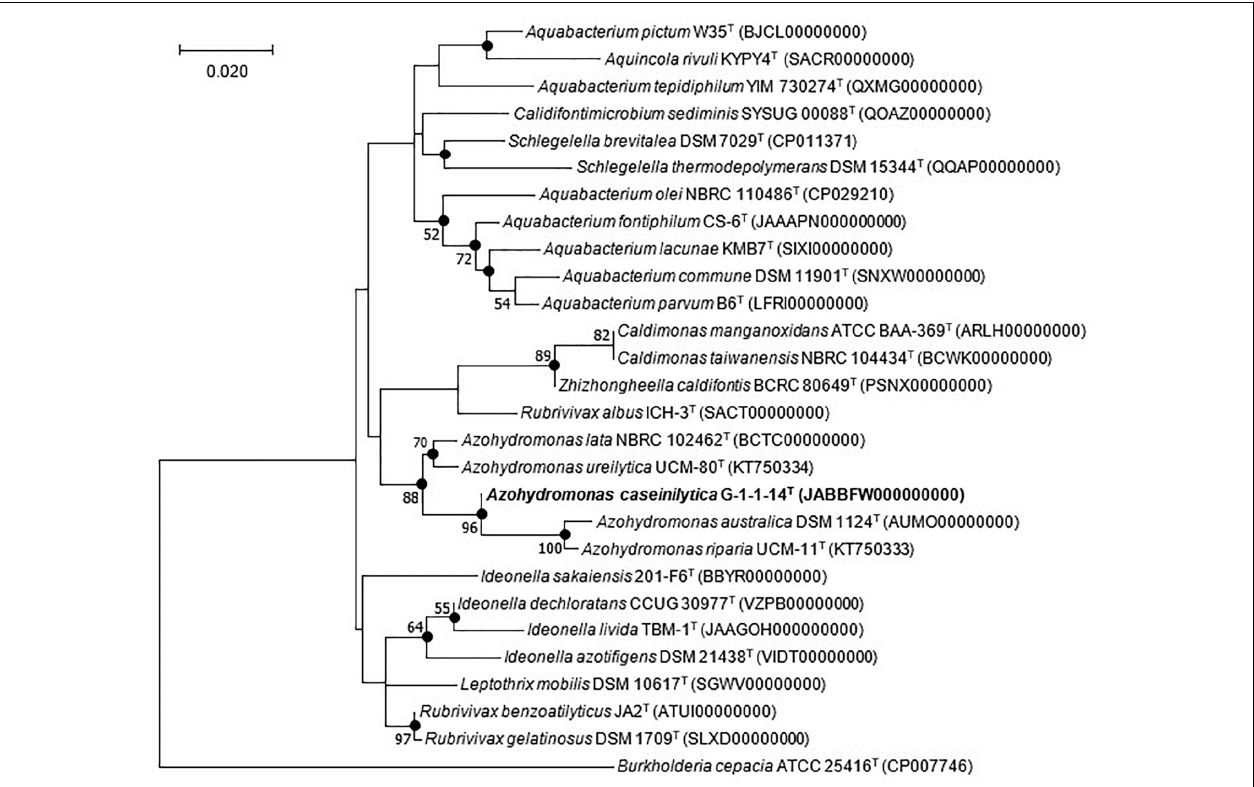
FIGURE 1 | Maximum likelihood tree based on 16S rRNA gene sequences showing the phylogenetic position of strain G-1-1-14 T among the closely related members of the order Burkholderiales. Filled circles indicate nodes recovered by all three treeing methods (neighbor-joining, maximum likelihood, and maximum parsimony). The numbers at the nodes indicate the percentage of 1,000 bootstrap replicates yielding this topology; only values > 50% are shown. Burkholderia cepacia ATCC 25416 T was used as an outgroup. The GenBank accession numbers are given in parentheses . Bar , 0.020 substitution per nucleotide position. Bold values indicates proposed